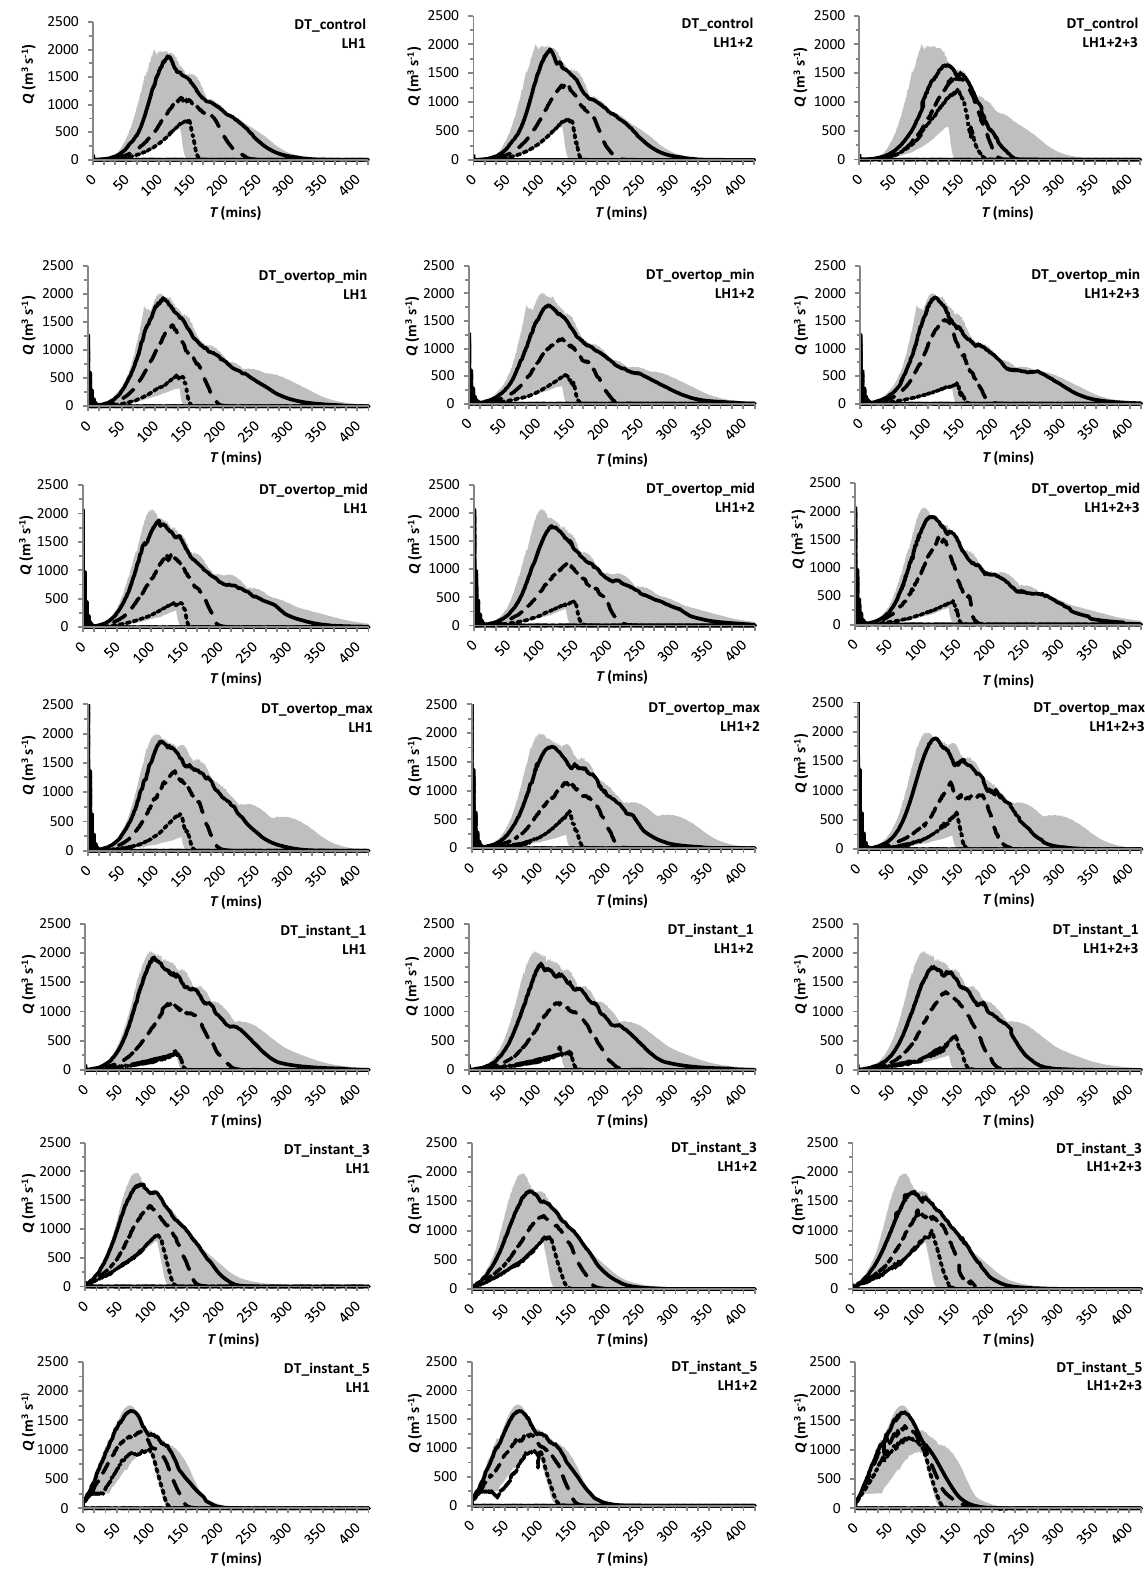
Figure 10. Percentile hydrographs derived from behavioural Dig Tsho simulations, for successive likelihood updating steps (“LH1”, “LH1 + 2”, “LH1 + 2 + 3”). Small dashes: 5th percentile; long dashes: 50th (median) percentile; solid black: 95th percentile. Behavioural hydrograph envelope is displayed in